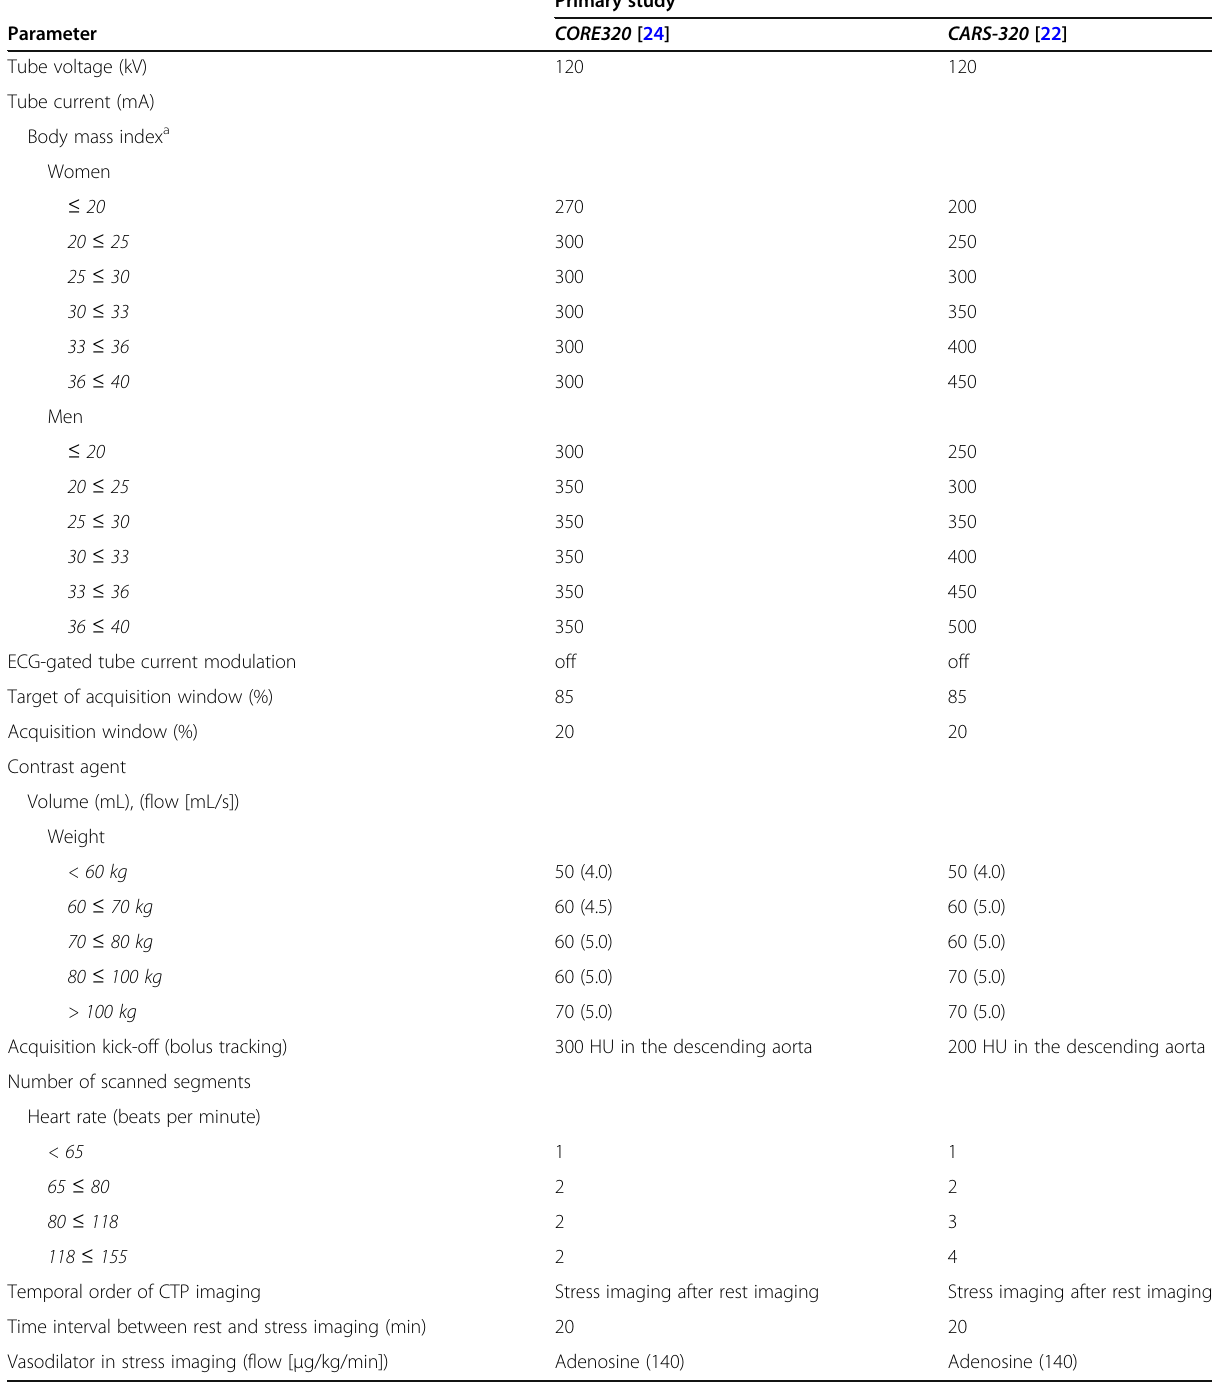
Table 1 Myocardial computed tomography perfusion raw data acquisition